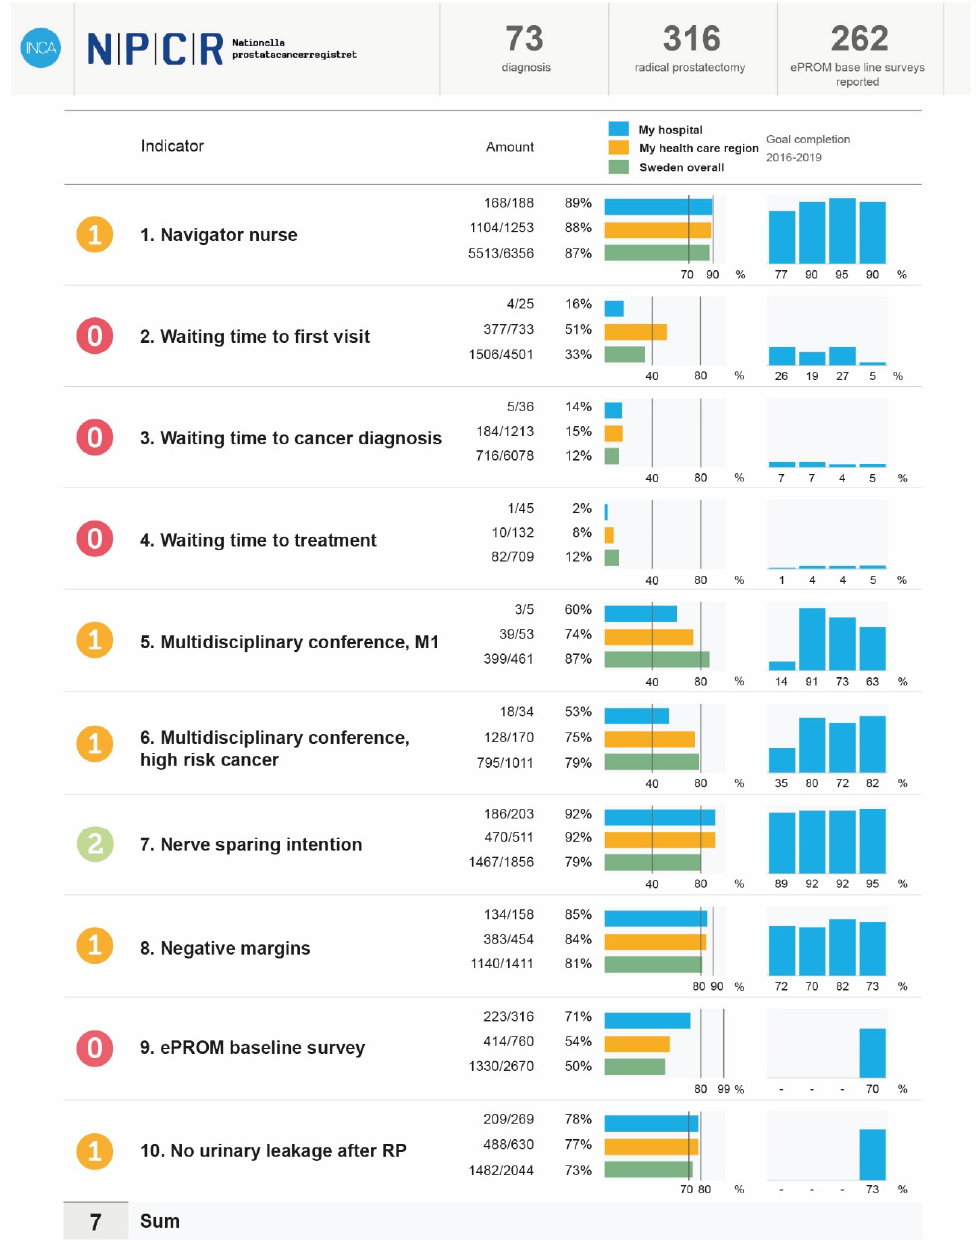
Figure 4. Quality indicator “Dashboard” for urologists. Definition of indicators (per treatment centre/county council/region) for new diagnoses during the reporting period: 1. Proportion of men with newly diagnosed prostate cancer who have a named contact nurse; 2. Proportion of men seen within a specialist clinic for suspected prostate cancer within 14 days of initial referral; 3. Proportion of men receiving notification of cancer diagnosis within 11 days of their prostate biopsy; 4. Proportion of men with a time interval between referral and initiation of curative primary treatment less than 61 days (radical prostatectomy, RP), 58 days (radiotherapy (RT) without neoadjuvant hormone therapy) or 50 days (neoadjuvant hormone therapy with RT) for men with high-risk cancer; 5. Proportion of men up to 80 years of age with primarily metastatic disease (M1), whose case was discussed at a multidisciplinary conference (MDC). The definition of a multidisciplinary conference in the National Prostate Cancer Register (NPCR) is that both a urologist and an oncologist participate; 6. Proportion of men up to 80 years with high-risk cancer without distant metastases, whose case was discussed at MDC. High-risk cancer is divided into localized high-risk cancer or locally advanced cancer; 7. Proportion of people who underwent surgery with a low- or intermediate-risk tumour who underwent intra/interfascial nerve-sparing resection; 8. Proportion of prostatectomy specimens with negative resection margins at pT2.; 9. Proportion of men who underwent prostatectomy who completed a baseline patient-reported outcome survey; 10. Non-severe urinary incontinence 12 months after radical